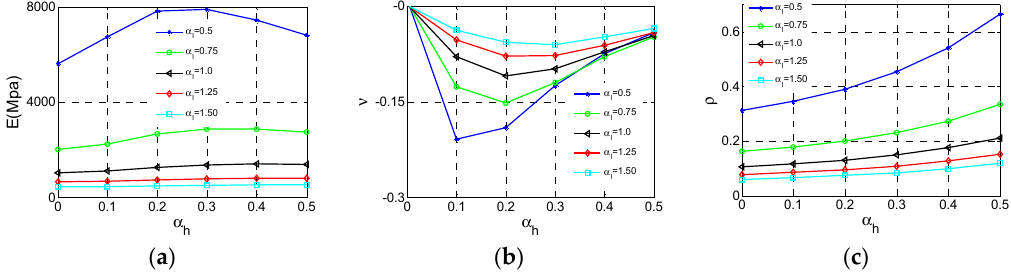
Figure 15. The changes of the effective properties with respect to the height ratio α h and the length ratio α l for Type D cell: ( a ) effective Young’s modulus E ; ( b ) effective Poisson ratio v ; ( c ) relative density ρ .